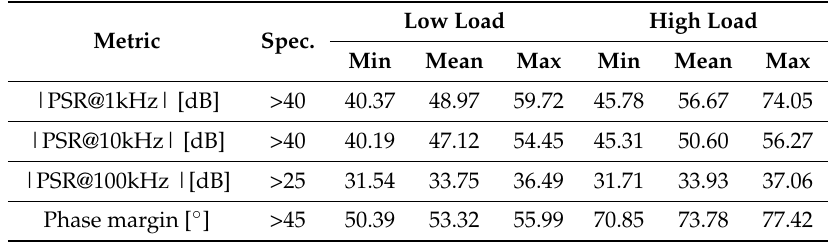
Table 6. Performance metrics of the Pareto front solutions obtained through NSGA-II optimization of the CL-LDO in the IBM 130 nm process measured with simulations.